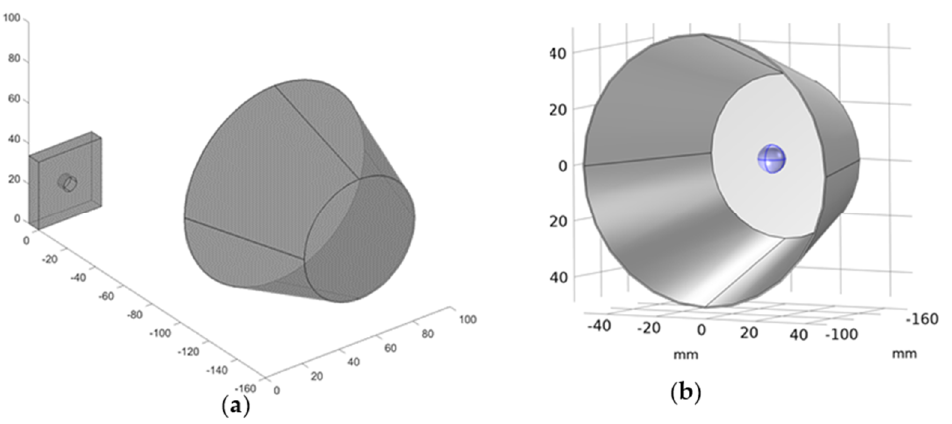
Figure 4. Numerical model geometry. ( a ) The view on the single−defect sample with the heat source, ( b ) detail of the modeled halogen lamp—heat reflecting, hollow cone with point heat source placed inside.